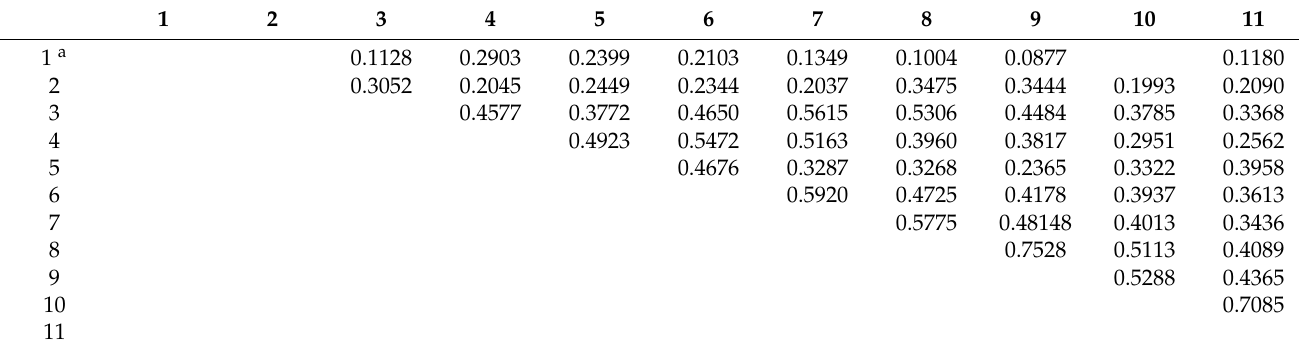
Table 3. Correlation of Selected Drinks consumed by Polish Adults, using Spearman’s rank correlation